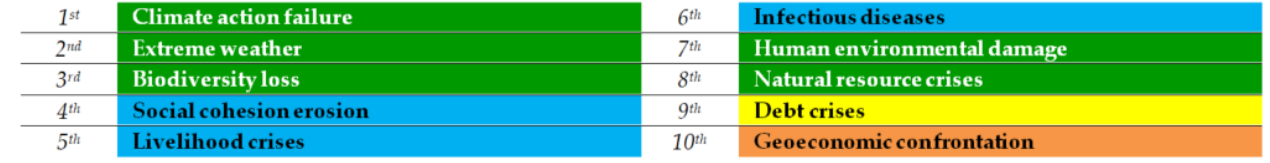
Figure 1. Identification of the most severe risks on the global scale over the next 10 years. Source: own study based on [2]. Areas analyzed: economic, geopolitical, societal, environmental. The European energy sector is in a transition phase. The energy sectors of individual countries are no longer merely separate national markets, but do not yet constitute a common European market. Regional markets (e.g., the Scandinavian market) are playing increasingly important roles and are often perceived as an intermediate step preceding the target single European market. The strive to reduce CO 2 emissions and, at present, ensure energy security affects the changes in the business model of the energy sector on a national scale [3].